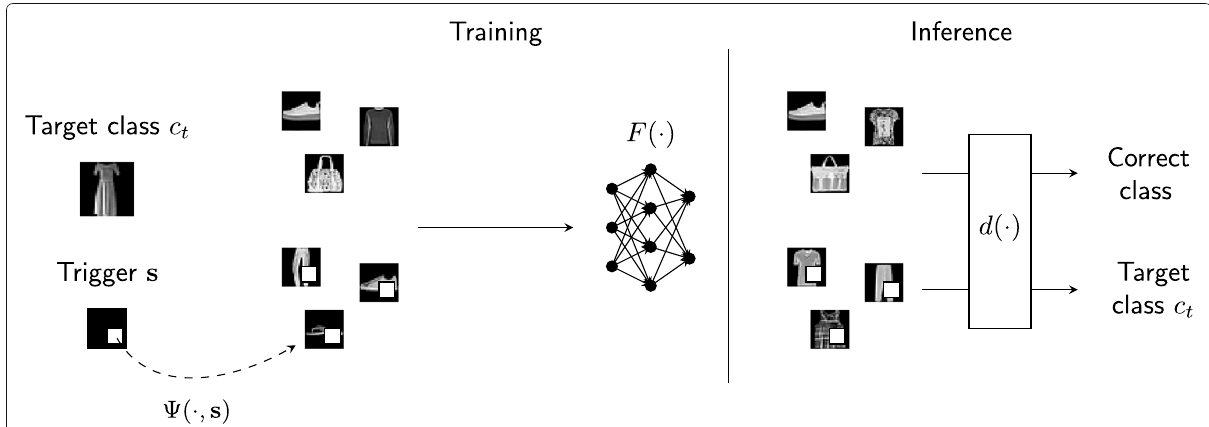
Fig. 1 Illustration of backdoor attacks. The training set typically contains s -infected samples labeled with the target class. At inference time, the model assigns samples containing the trigger to the target class, while classifying clean samples